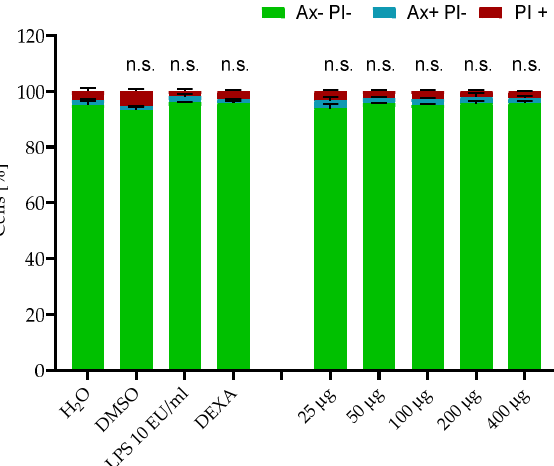
carbon (yellow), oxygen (red), phosphor (green), calcium (blue), and iron (violate) and are shown.